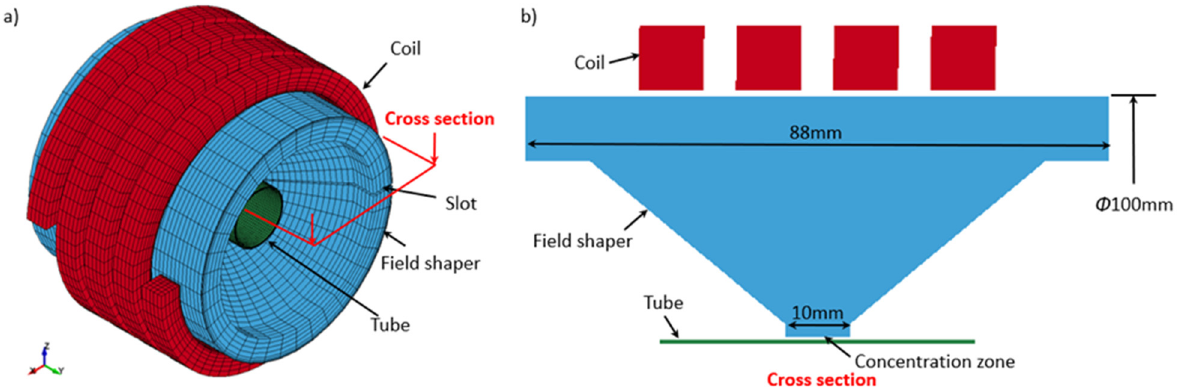
Figure 7. EMF model defined in LS-PREPOST ( a ) 3D model, ( b ) cross-section.